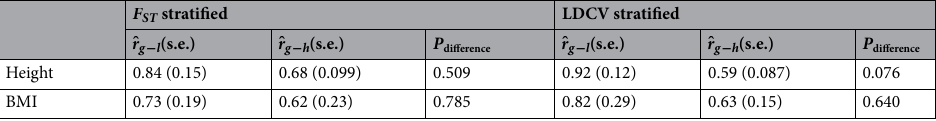
Table 2. Difference of the estimated ˆ r g for EUR-AFR between SNP sets stratified by allele frequency- and LD-matched F ST (and LDCV) for height and BMI respectively. l and h indicate the SNP group with lower F ST (or LDCV) and higher F ST (or LDCV),